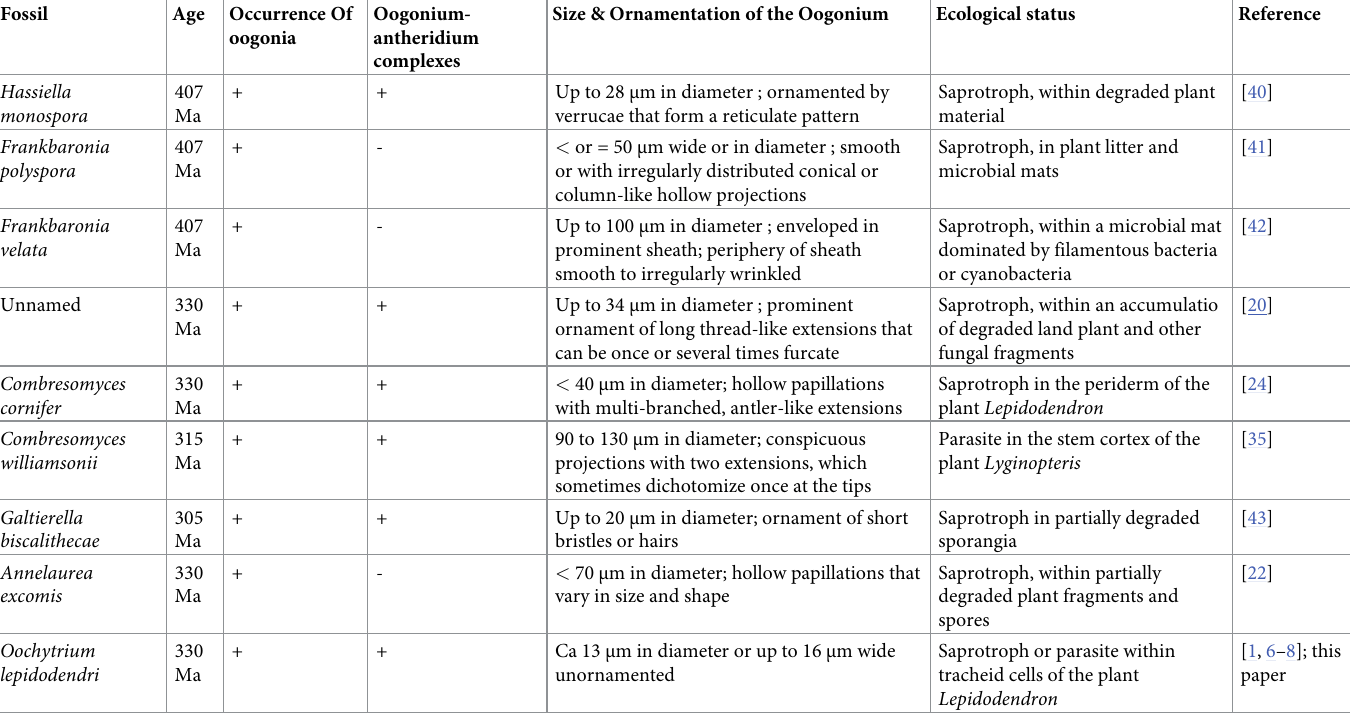
Table 1. Comparison between oomycetes described from Devonian and Carboniferous